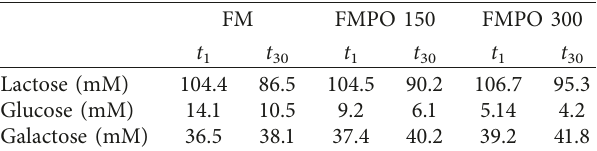
Table 6: Volatile compounds (ppm) of FMPO 150, FMPO 300, and FM during